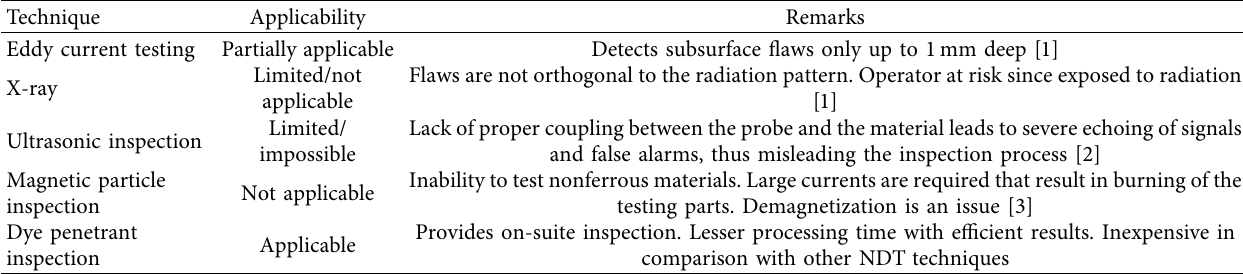
Table 1: Applicability and novelty of the proposed